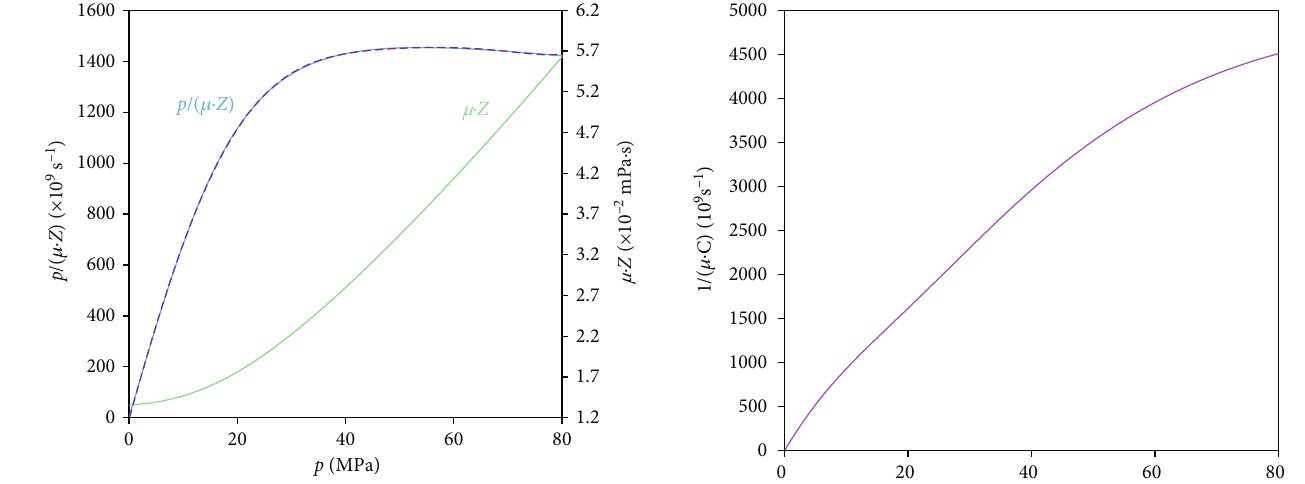
Figure 17: Relation curves of p / ð μ Z Þ and μ Z vs. pressure ( p ) for the high-pressure cases.